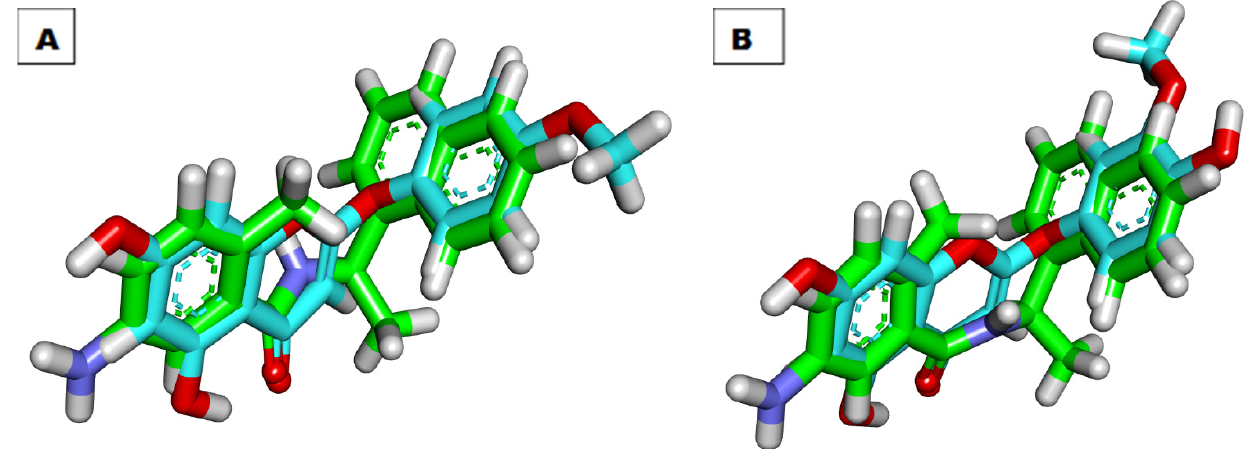
Figure 5. ( A ) Flexible alignment of compounds 1 (turquoise) TTT (green). ( B ) Flexible alignment of compounds 2 (turquoise) with TTT